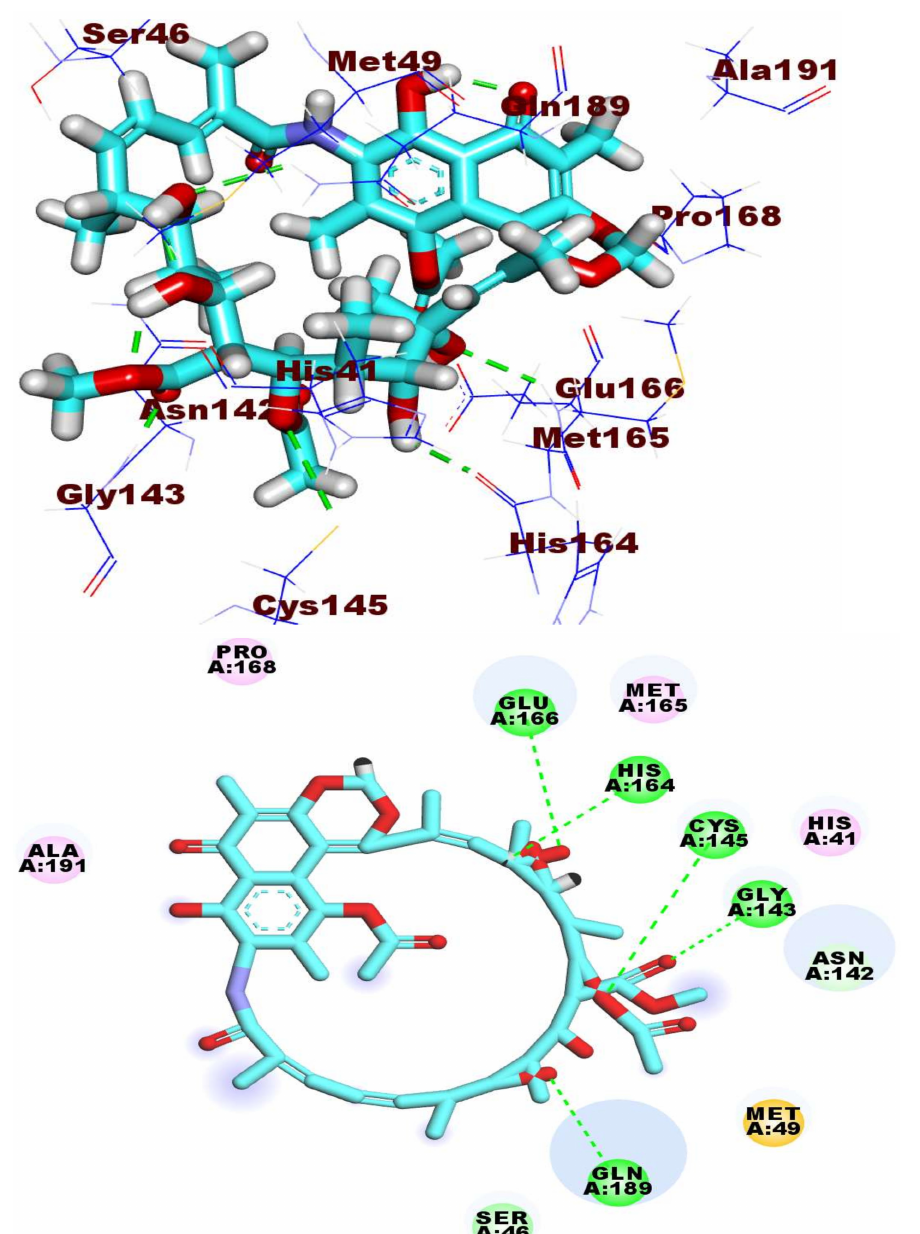
Figure 8. Binding mode of compound 278 inside the active site of M pro PDB ID: